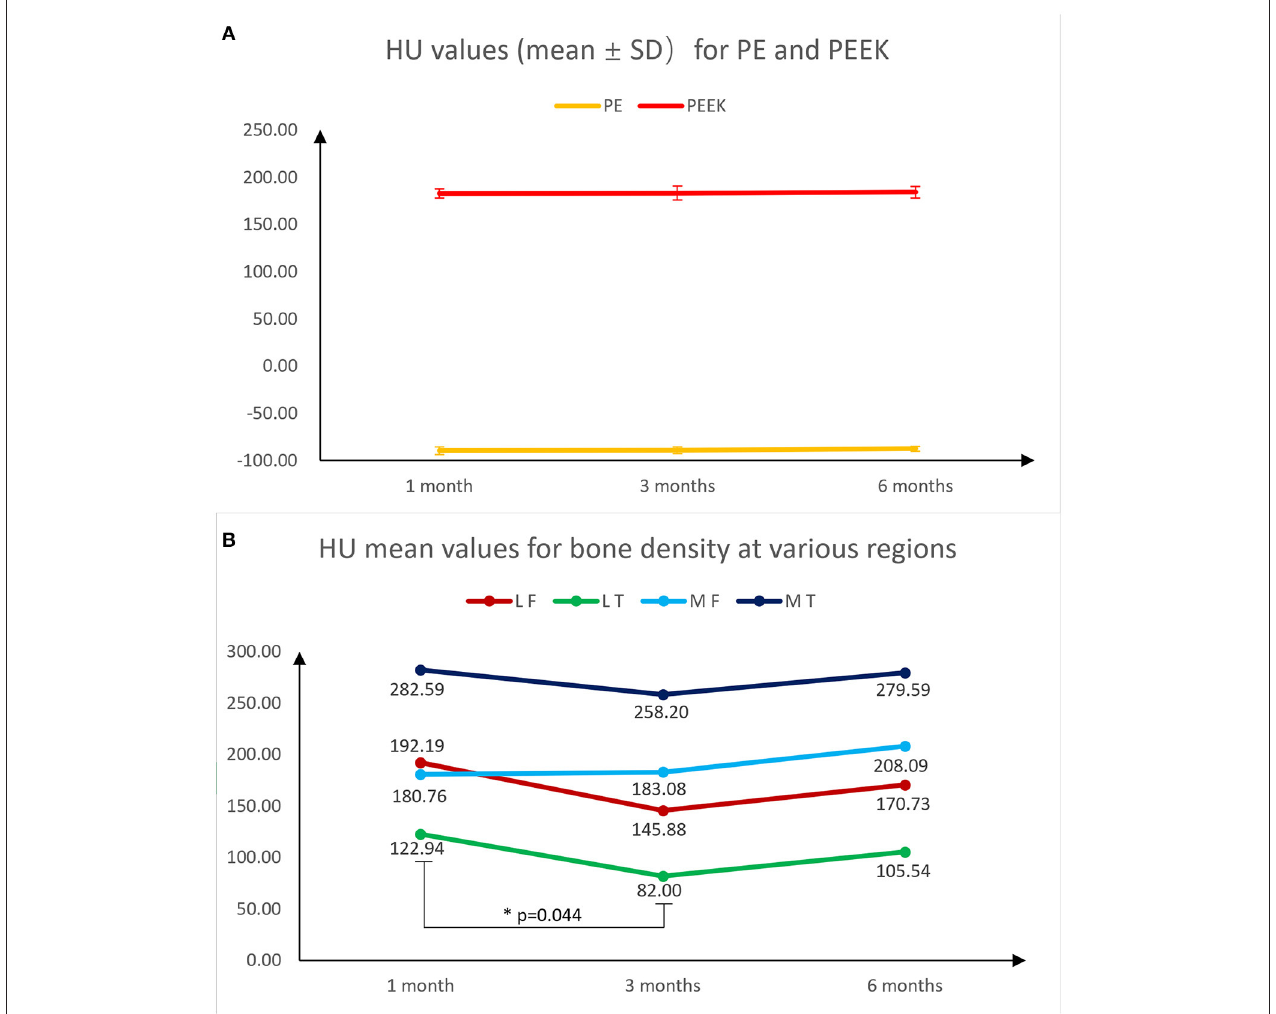
FIGURE 6 | Fold plots of the change in HU values of PE, PEEK, lateral femur, lateral tibia, medial femur and medial tibia measured using CT at 1, 3, and 6 months postoperatively, which reflect the trend of density change in the measured area. Among them, the mean and standard deviation of HU values for PE and PEEK were almost unchanged (A) . Except for the medial femur, which did not decrease at 3 months, there was a trend of decreasing bone density at 3 months in the remaining regions, with a statistically significant decrease in the medial tibia. All regions showed a rebound in bone density at 6 months (B)